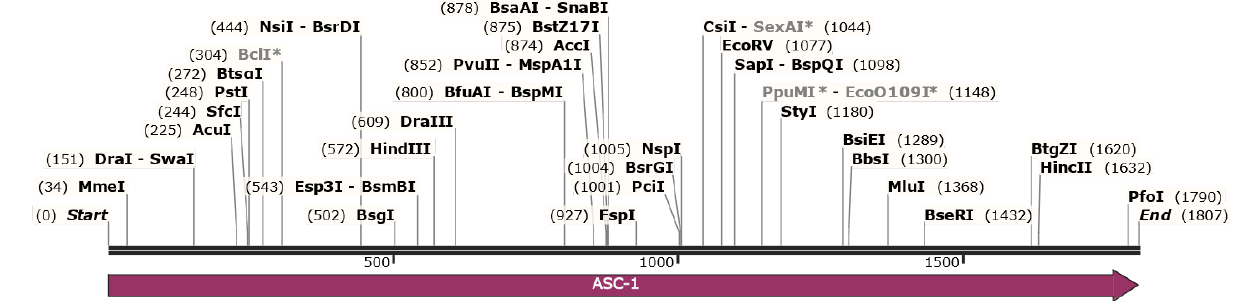
Figure 3. Co-predominant ASC-1 gene identified in both A. alternata and Septoria lycopersici , pathogens that cause necrotic spots in plants, located on chromosome 3. * Methylation prohibited breakpoints similar to Dam methylation (*) [65].